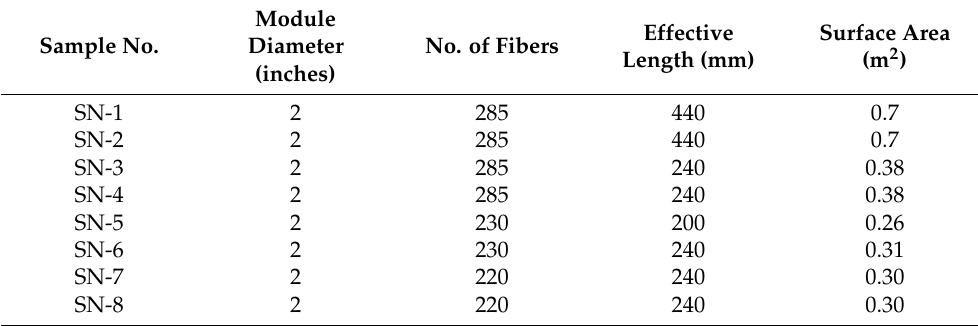
Table 5. Specifications of module variables for flux optimization under DCMD and VMD testing modes using 2-inch modules.